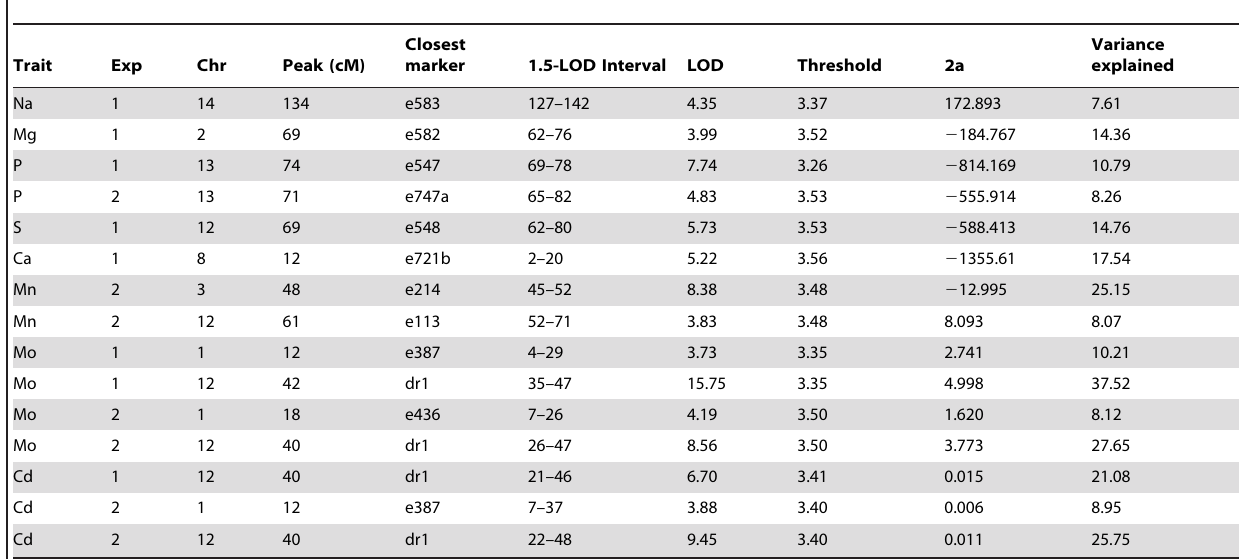
Table 3. Leaf mineral nutrient QTLs discovered by composite interval